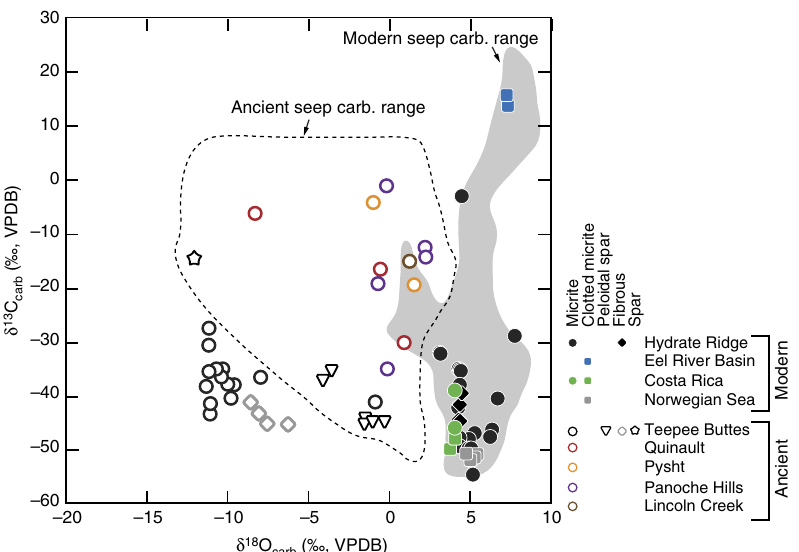
Figure 4 | Carbon and oxygen isotope values of modern and ancient cold seep carbonates. Ranges of previously reported values denoted by the grey envelope (modern 4,11,12,32,37,39 ) and dashed outline (ancient 11,38,42 ). Notice predominance of depleted d 13 C carb values, typical of AOM carbonates. The enriched d 18 O carb values expressed by modern cold seep carbonates has been interpreted to reflect incorporation of clathrate-dissolution-derived oxygen. Eel River Basin samples (micritic dolomites) exhibit positive d 13 C carb values, indicative of a methanogenesis origin.